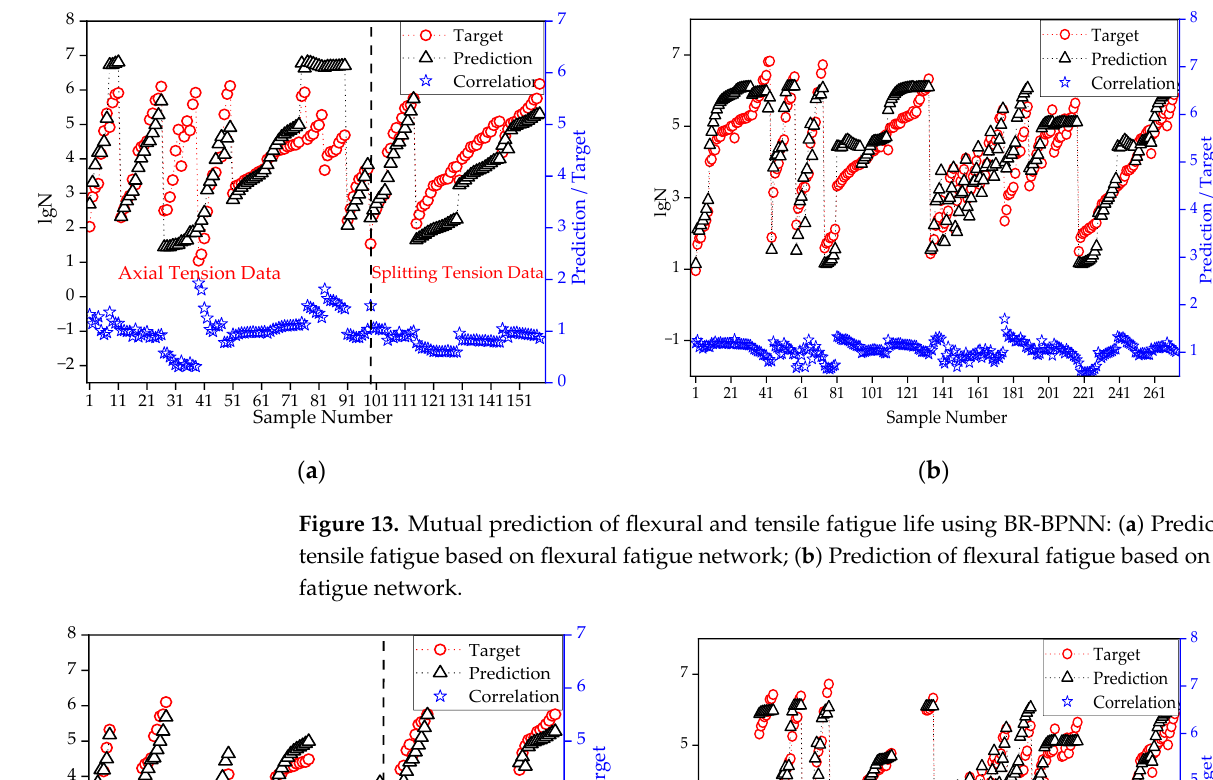
Figure 13. Mutual prediction of flexural and tensile fatigue life using BR-BPNN: ( a ) Prediction of tensile fatigue based on flexural fatigue network; ( b ) Prediction of flexural fatigue based on tensile fatigue network.